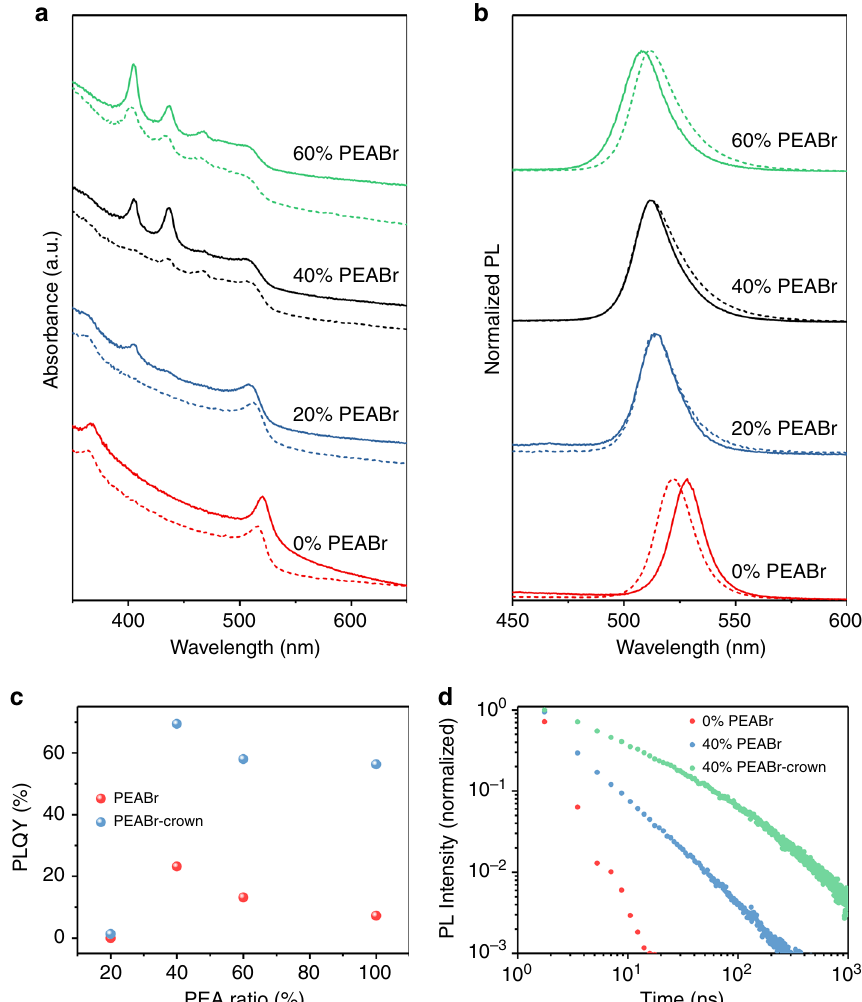
Fig. 2 Absorption, PL, PLQY, and time-resolved PL of the perovskite fi lm. a Optical absorption and b PL for the perovskite fi lms without (solid lines) or with (dashed lines) crown for different PEABr ratios. c PLQY (excited at 365 nm at approximately 2.3 mW cm − 2 ) versus PEABr ratio for the perovskite with and without crown. d Time dependence of PL intensity for the perovskite fi lms with 0% PEABr (red), 40% PEABr (blue), and 40% PEABr-crown